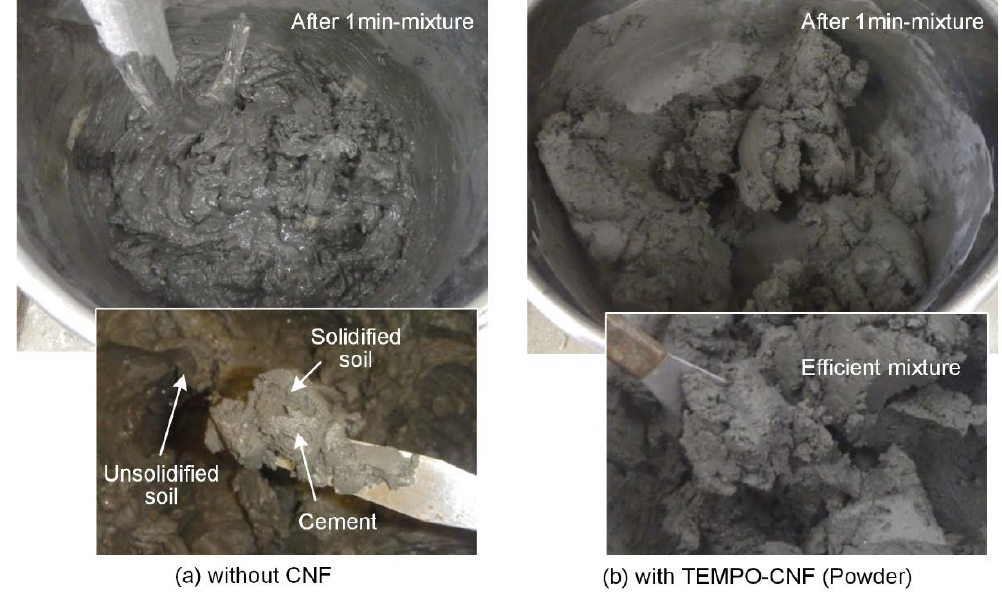
Figure 4. Appearance immediately after mixture by Method 2.